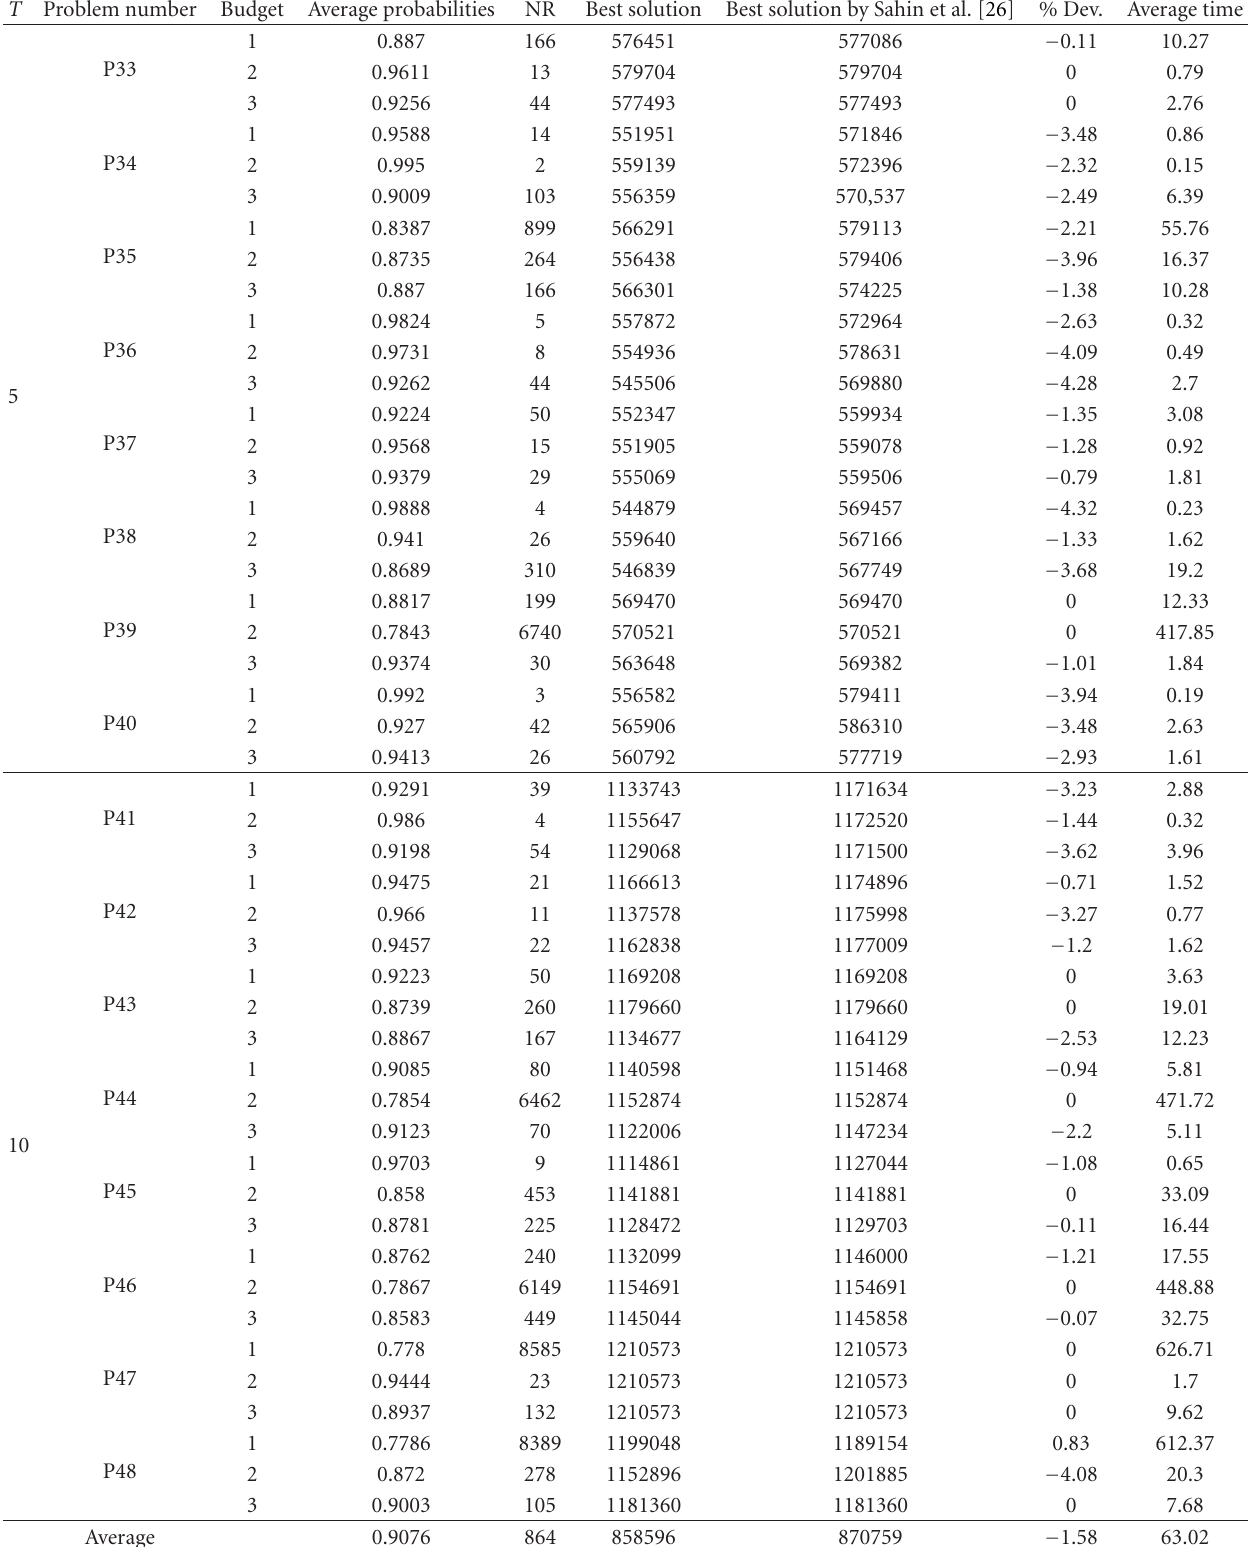
Table 3: The computational results with significant level 99% with N =